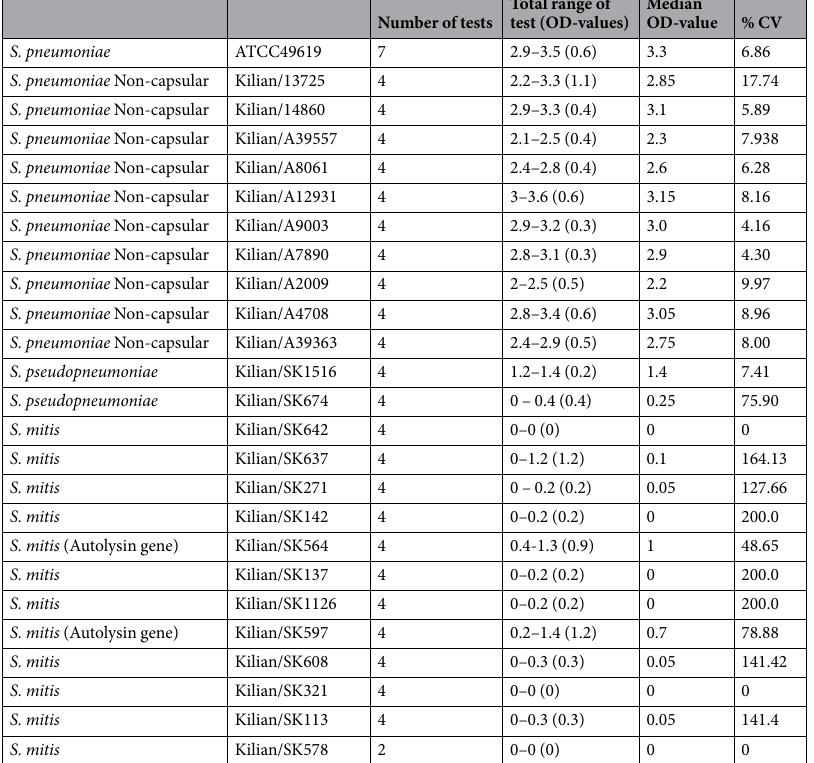
Table 4. Repeated testing of 25 strains over time and performed by different persons. OD-values below 0 are considered as 0.0. For detailed data see supplementary Table